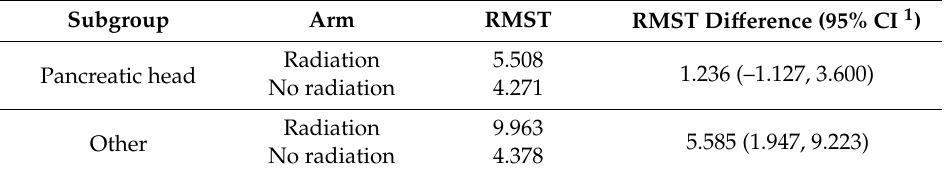
Table 1. Restricted mean survival times (RMSTs) for the arms with and without radiation, for the pancreatic head and “other” subgroups, and the RMST di ff erences between the two arms. Subgroup